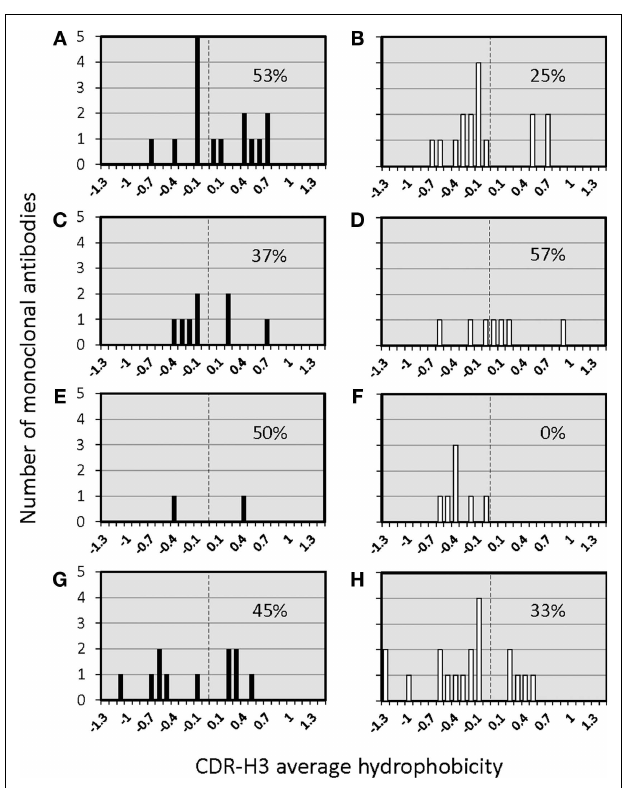
FIGURE 5 | Distribution of average hydropathicity values of CDR-H3 loops of monoclonal anti-phOxAb of D-altered ∆ D-D µ FS mutant mice . The average hydropathicity values of CDR-H3 loops were calculated with the normalized Kyte–Doolittle hydrophobicity scale (8). Anti-phOx antibody-secreting hybridomas (IgM black bars, IgG white bars) were generated after primary immunization on day 7 (A) IgM ( n = 16 mAb), (B) IgG ( n = 14 mAb), and on day 14 (C) IgM ( n = 8 mAb), (D) IgG ( n = 7 mAb), 3days after secondary immunization (E) IgM ( n = 2 mAb), (F) IgG ( n = 7 mAb), 3days after tertiary immunization, (G) IgM ( n = 11 mAb), and (H) IgG ( n = 17 mAb). See also Figure S3 in Supplementary